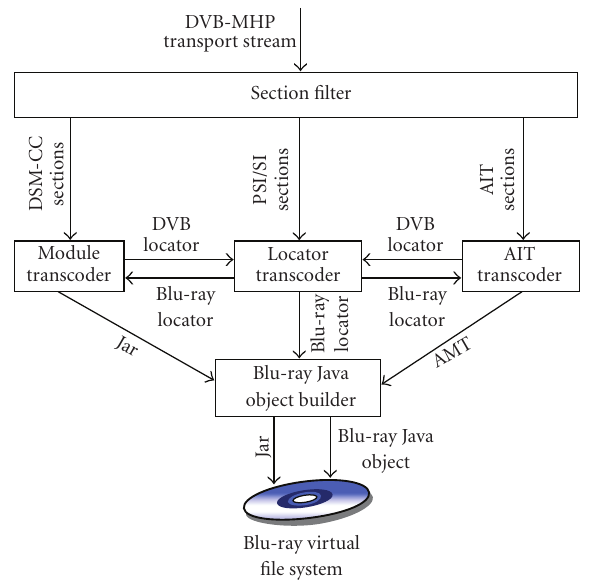
Figure 8: Block diagram of the DVB-MHP to Blu-ray interactive data